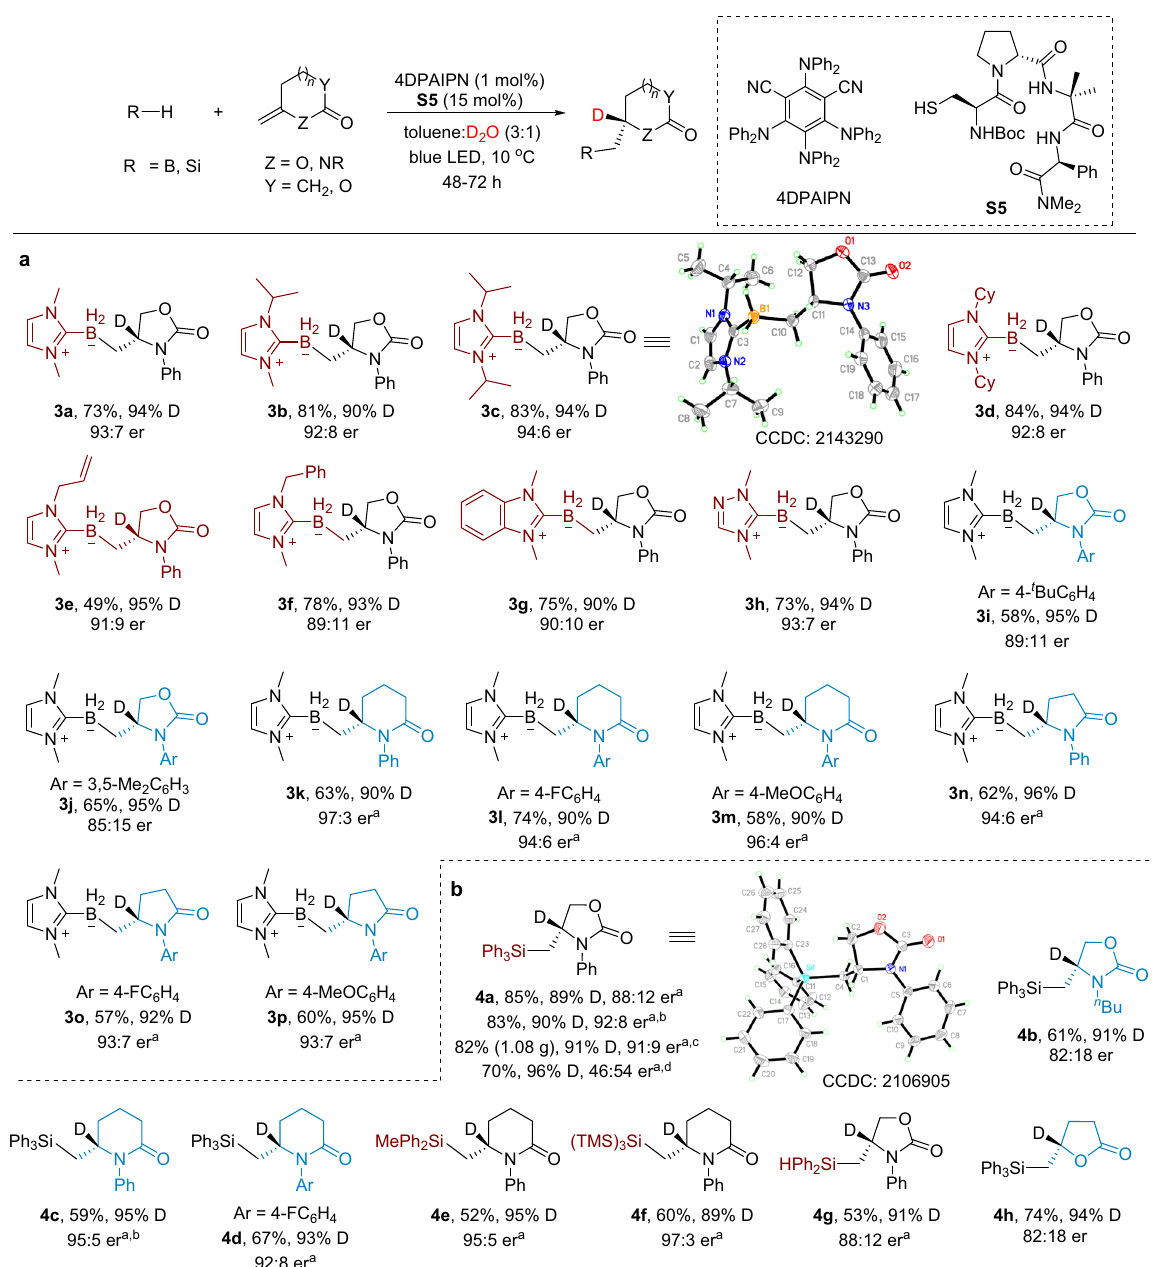
Fig. 2 | Peptidic thiol-catalyzed enantioselective deuterofunctionalization of exocyclic ole fi ns. a Enantioselective deuteroboration. b Enantioselective deuter- osilylation. Yield, deuterium incorporation, and er are for isolated products; see